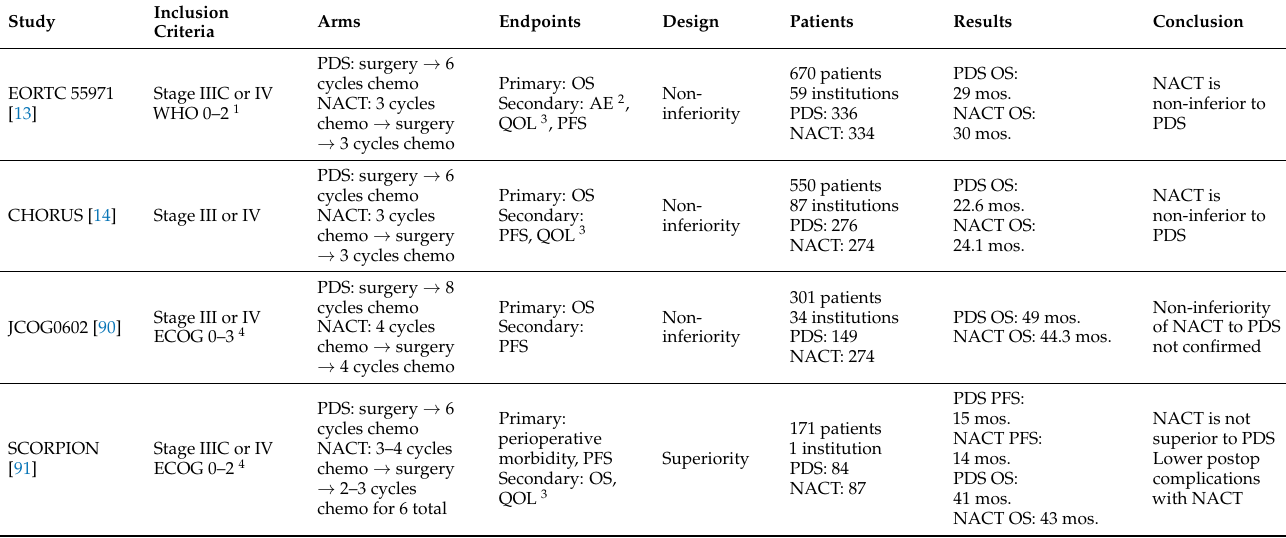
Table 3. Comparison of randomized trials comparing NACT to